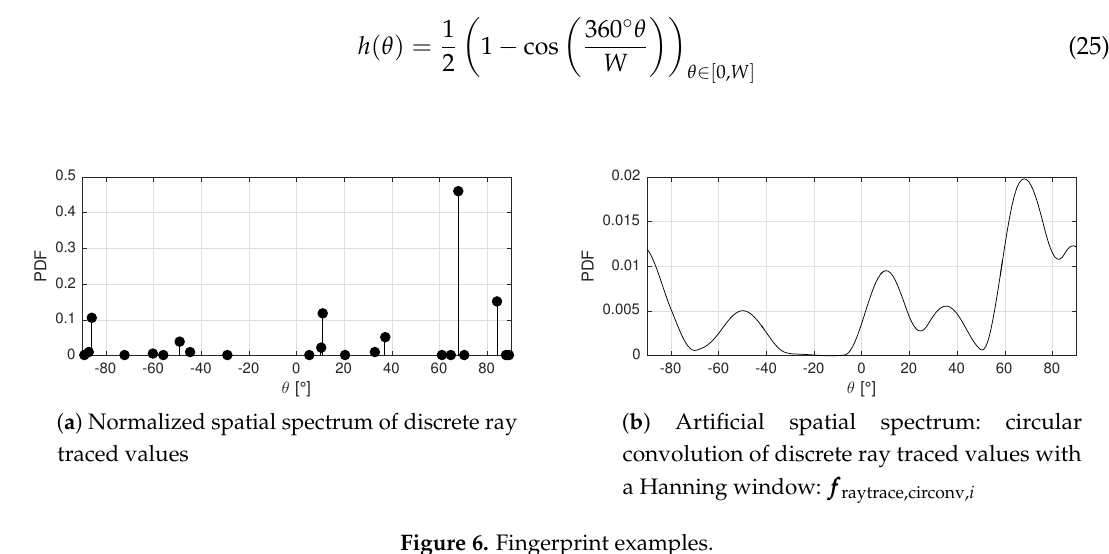
Figure 6. Fingerprint examples.